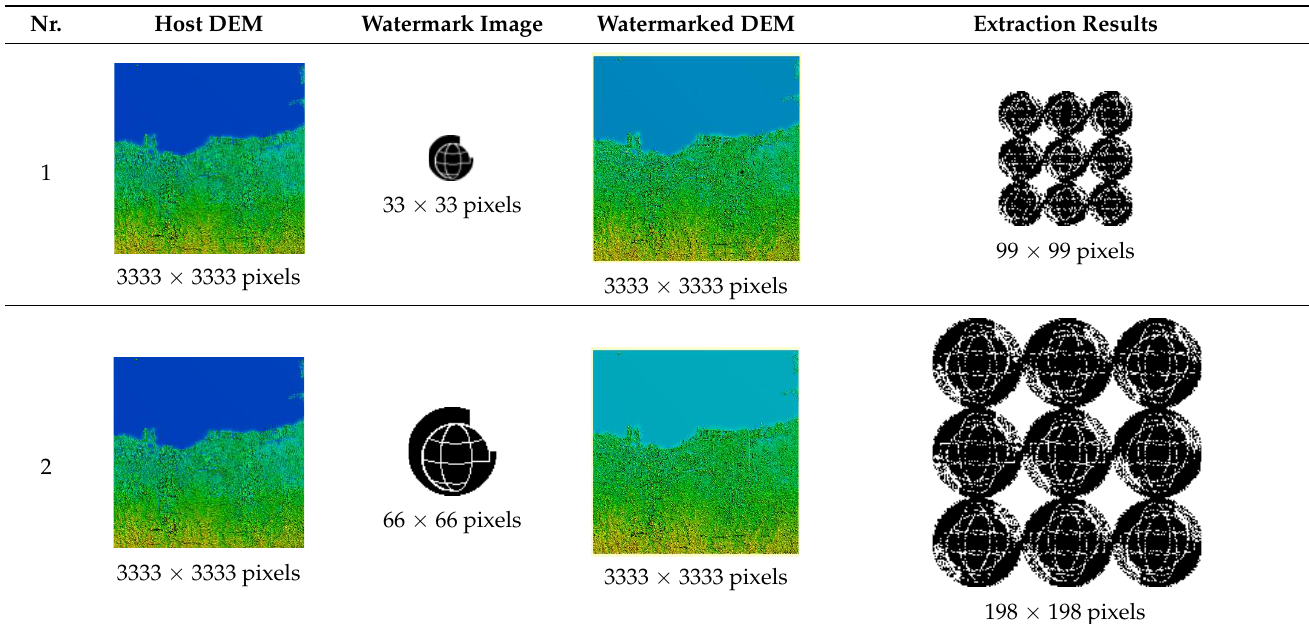
Table 11. Results of Experiment 2 (2D DFT technique).